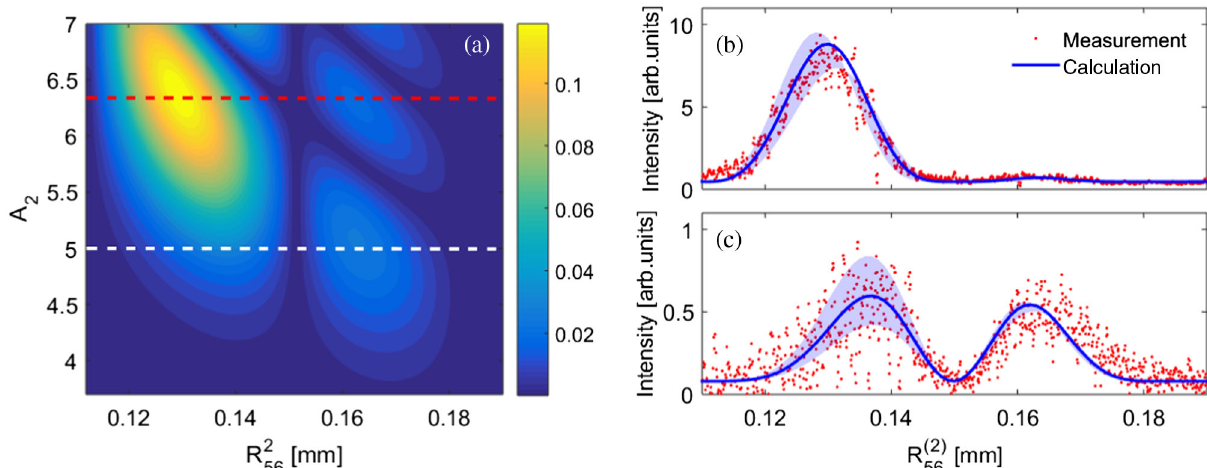
FIG. 3. (a) Theoretical bunching distributions for A 1 ¼ 3 . 5 and R 1 56 ¼ 2 . 2 mm. Measured intensity of the coherent radiation at the 20th harmonic as a function of R 2 56 for A 2 ¼ 6 . 3 (b) and A 2 ¼ 5 (c). The blue shadow in (b) and (c) represents the calculation results with a power fluctuation of 4% for the second seed